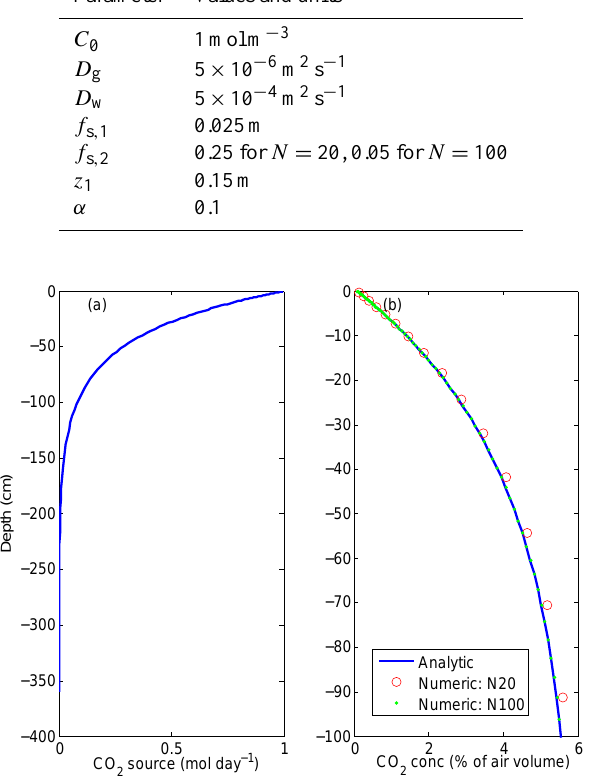
Figure 2. Comparison between the numerical and analytical solu- tions for the steady-state soil CO 2 model: (a) net CO 2 source pro- file, as specified in the second term of Eq. (11); (b) analytical and predicted soil CO 2 profiles. N20 indicates solution using 20 numer- ical layers and N100 indicates solution using 100 numerical layers. At the top boundary, the CO 2 concentration equals